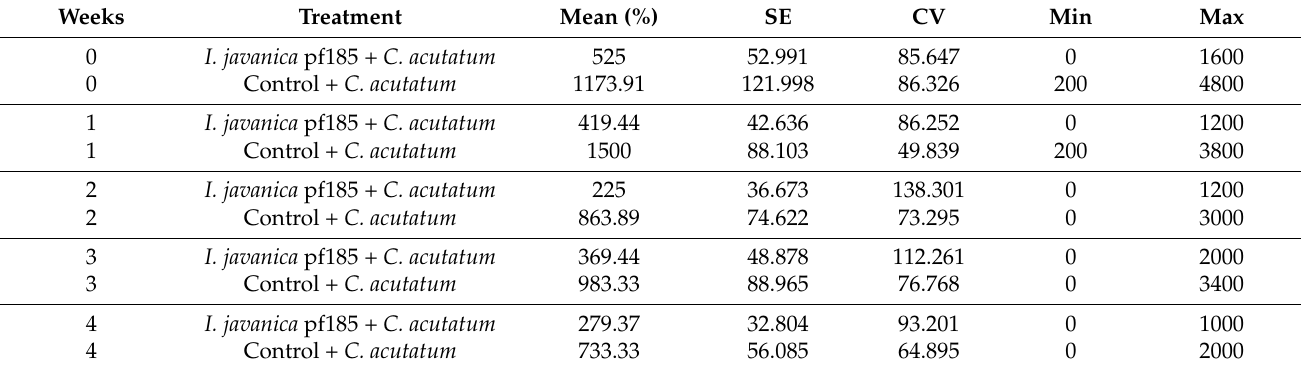
Figure 5. Weekly evolution of the ILD rate per treatment during the experiment. Means with the same letters (a, b, c, d, e, f, g, h) do not differ significantly. Table 3. Summary of the weekly ILD per treatment during antifungal assessment.